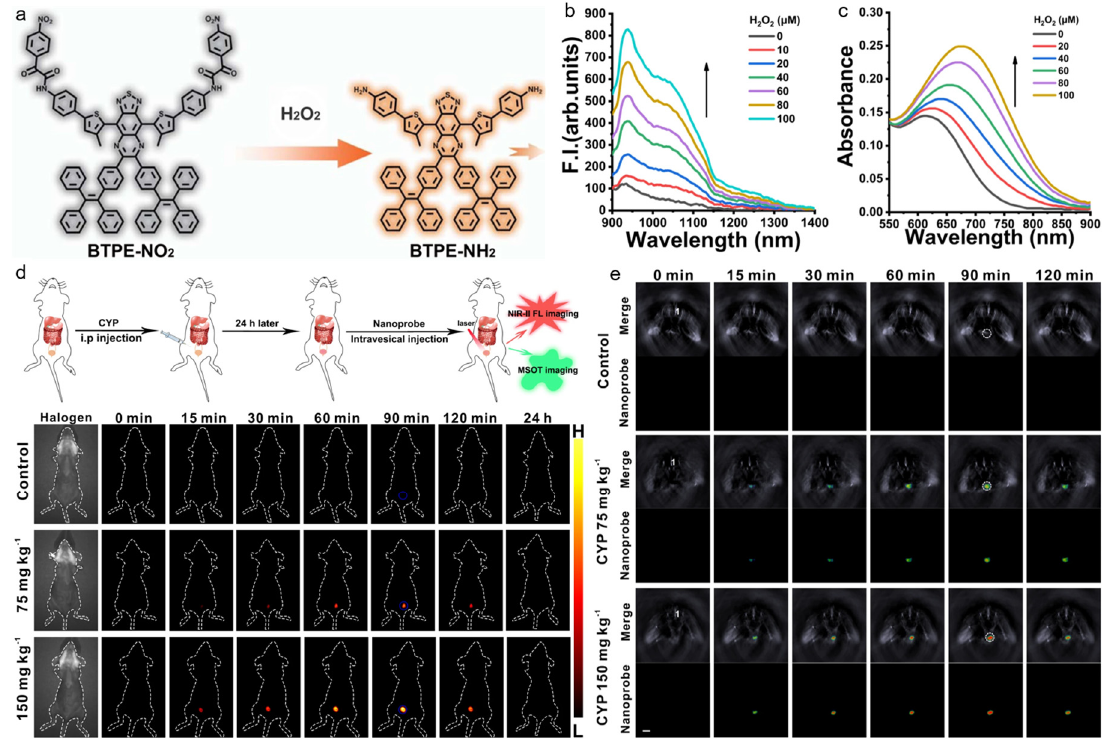
Figure 7. ( a ) The AIE probe for H 2 O 2 detection; ( b ) PL and ( c ) absorption spectra of BTPE-NO 2 with the treatment of different concentrations of H 2 O 2 ; ( d ) NIR-II fluorescence and ( e ) PA imaging of interstitial cystitis mice with different treatments at designed time points after administration. (Reproduced with the permission from Ref. [127]. Copyright 2021, The